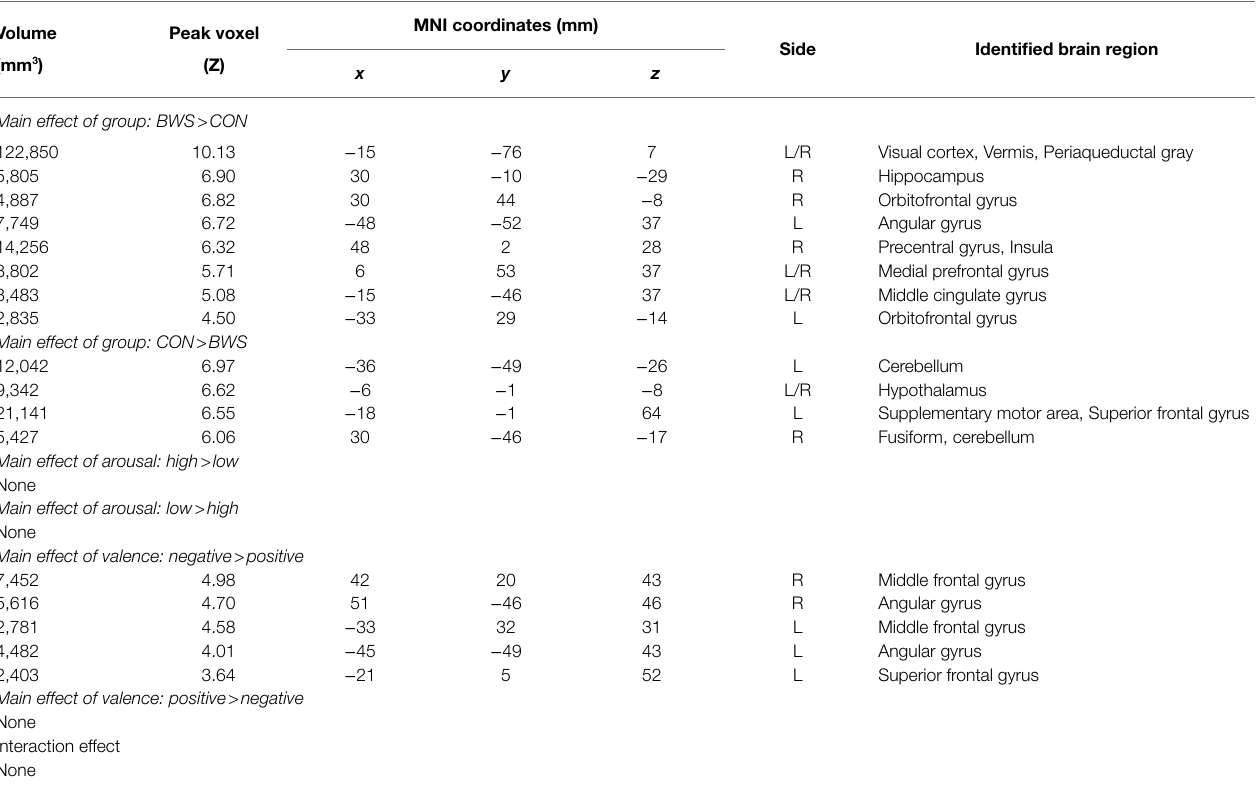
TABLE 2 | Regions showing activations in ANOVA model of group (BWS vs. CON) by arousal (high vs. low) by valence (negative vs.